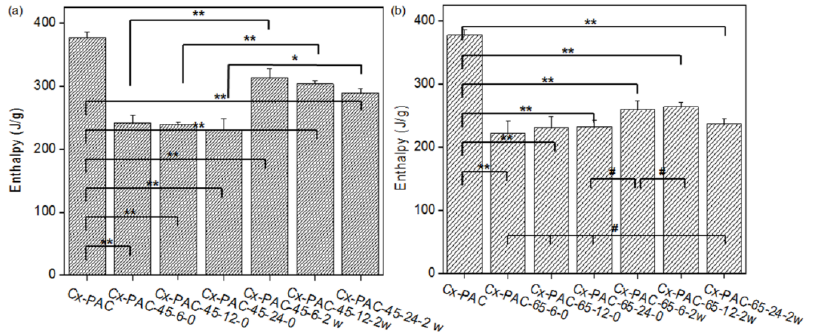
Figure 3. Enthalpy of Cx ‐ PAC film aged zero and two weeks at room temperature for each Cx ‐ PAC film before and after thermal treatment at ( a ) 45 °C and ( b ) 65 °C (* p < 0.05, ** p < 0.001, # p > 0.001).